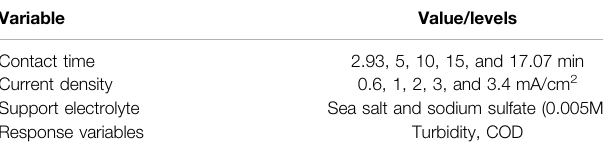
TABLE 1 | Operational conditions for EC